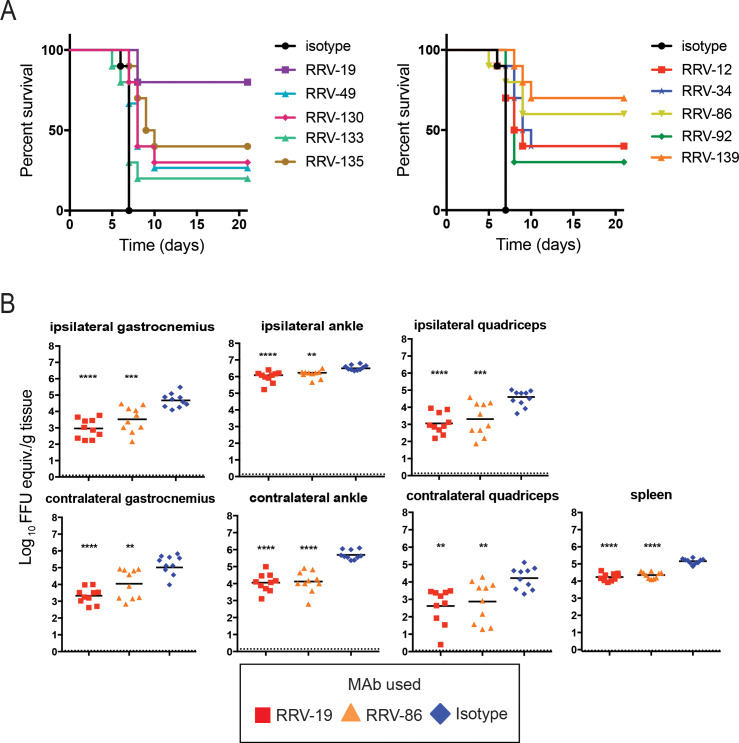
RRV mAbs increase mice survival rates when administered therapeutically.(A) WT C57BL/6 mice were given 0.2 mg of anti-Ifnar1 mAb, and subsequently inoculated with 103 FFU of RRV in the footpad. At day one post-infection, 100 μg of RRV mAb was administered. Antibodies are grouped according to neutralization profiles, with those exhibiting incomplete neutralization in vitro on the left and those exhibiting complete neutralization in vitro on the right. Two independent experiments were performed, with a total of n = 10 for each antibody group. The isotype control in the two graphs are the same. Statistical analysis was performed using a log rank test with Bonferroni correction: RRV-12, p = 0.0057; RRV-19, p < 0.0001; RRV-34, p < 0.0001; RRV-49, p = 0.0038; RRV-86, p = 0.0021; RRV-92, p = 0.0013; RRV-130, p = 0.0004; RRV-133, p = 0.3771; RRV-135, p < 0.0001; RRV-139, p < 0.0001. (B) 100 μg of RRV-19, RRV-86, or an isotype control were administered 24 h post-infection to WT immunocompetent C57BL/6 mice, and the ipsilateral and contralateral gastrocnemius, quadriceps, ankle, or spleen tissues were collected 3 dpi. Viral RNA was quantified through qRT-PCR. Two independent experiments were performed, with a total of n = 10 mice for each antibody group (one-way ANOVA with a Dunnett’s post-test comparing each group to the isotype control; **p < 0.01, ***p < 0.001, ****p < 0.0001).